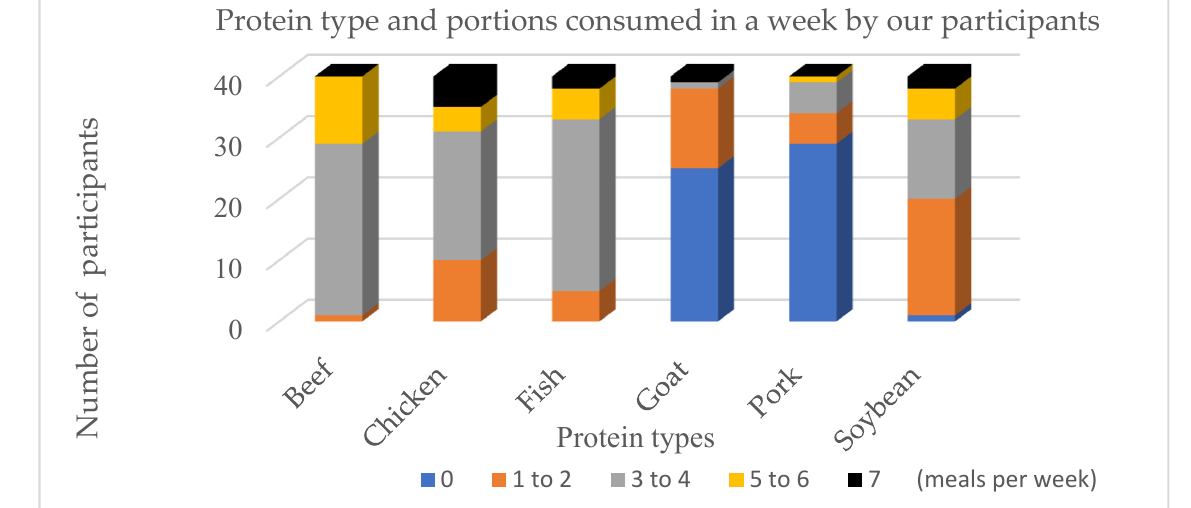
Figure 1. Protein source types and frequency of its consumption by 40 participants. Protein sources including beef, chicken, fish, goat, pork, and soybean, and frequency meals per week including 0, 1–2, 3–4, 5–6, and 7 times per week.